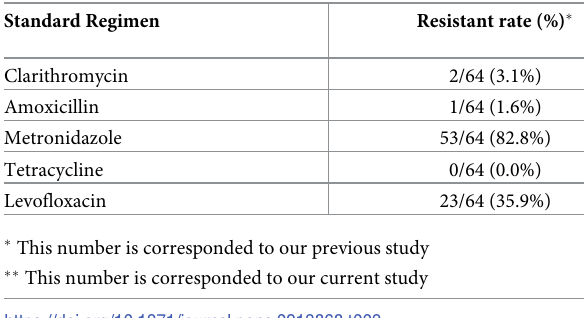
Table 3. Comparation susceptibility test of alternative vs. standard